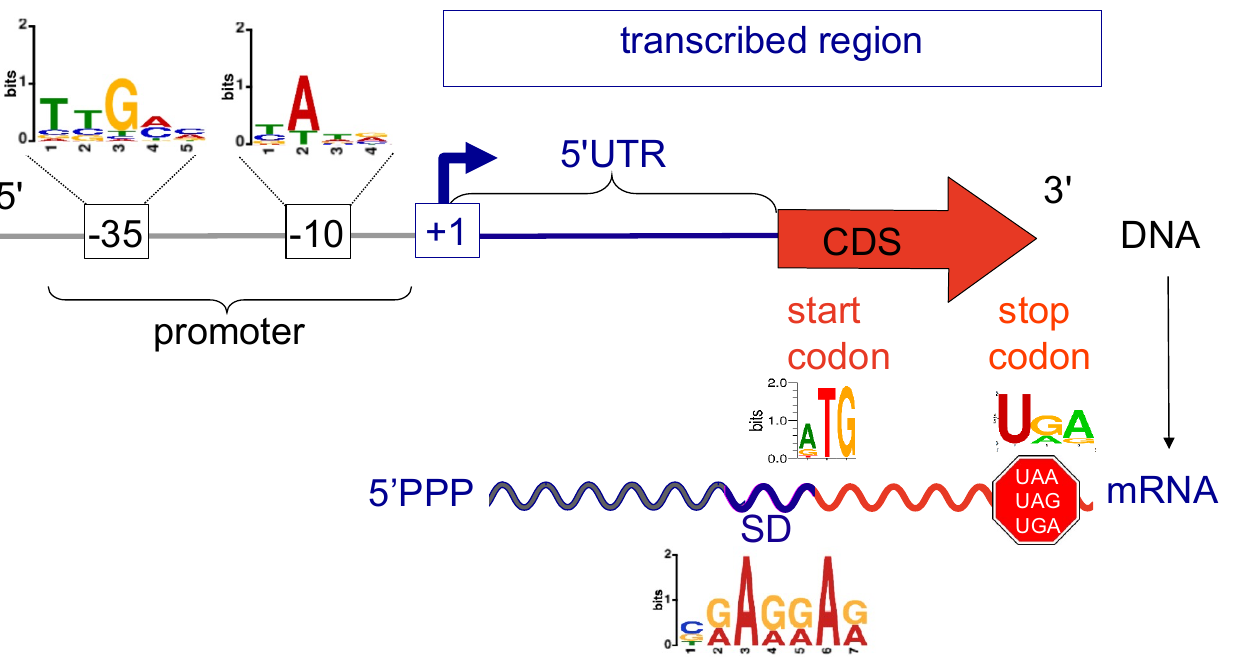
Figure 4. Remarkable nucleic acid motifs associated with M. extorquens DM4 gene expression. Transcription features (this work) and translation features [11] are shown. The −35 and −10 consensus sequences were deduced from TSS (P and IP) on the chromosome.